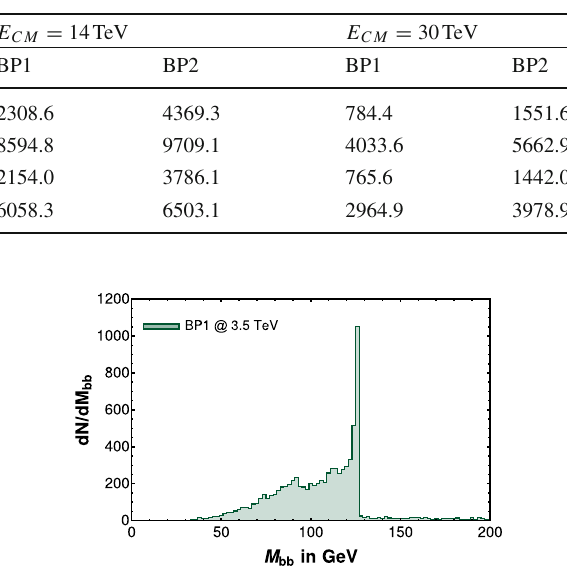
Fig. 25 Di- b -jet ( M bb ) invariant mass distributions for BP1 ( M N = 1 TeV) at the muon collider with Y N = 5 × 10 − 7 and centre of mass energy 3.5 TeV. The dominant peak around the SM Higgs boson mass (125.5 GeV) along with a small peak around the Z boson mass (91.1 GeV) are visible